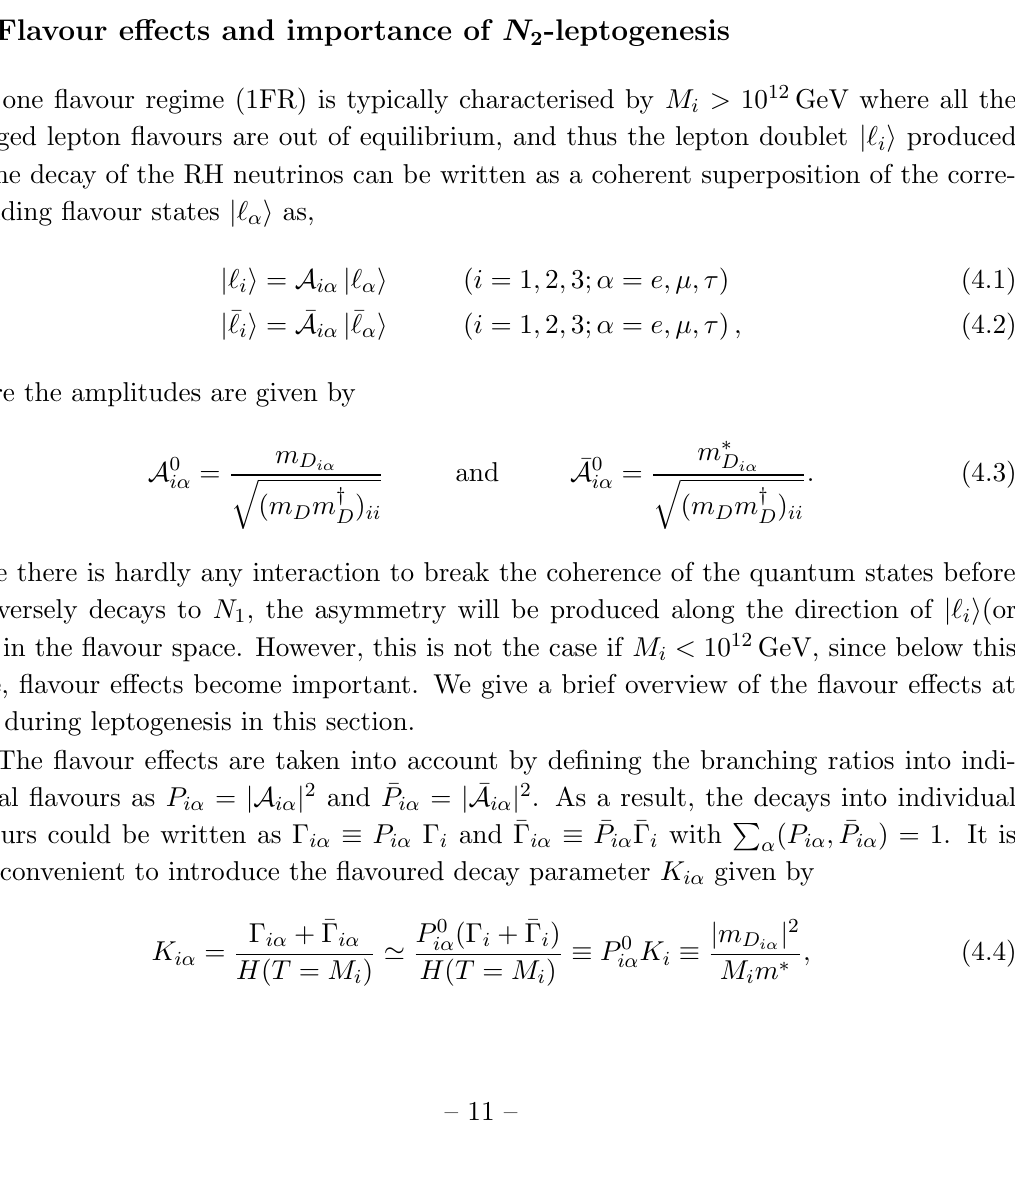
as the e(cid:14)ciency factor in a hierarchical scenario, as a 1 to (cid:20) 1 for di(cid:11)erent values of (cid:14) 12 and K 2 . 1 1